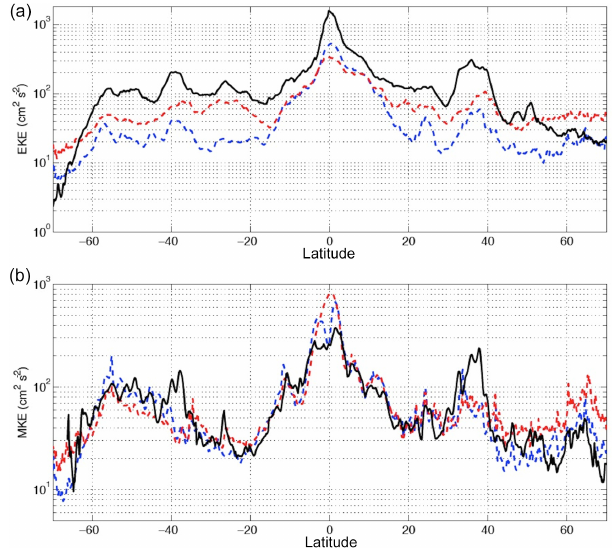
Figure 12. (a) Latitudinal profiles of the global zonal-mean eddy ki- netic energy (EKE) (in cm 2 s − 2 ) of the surface flow for 2013 from GLOB16 (red), GLOB4 (blue), and OSCAR (black). Scale is loga- rithmic. (b) As panel (a) but for the kinetic energy of the mean flow (MKE) of the surface flow (in cm 2 s − 2